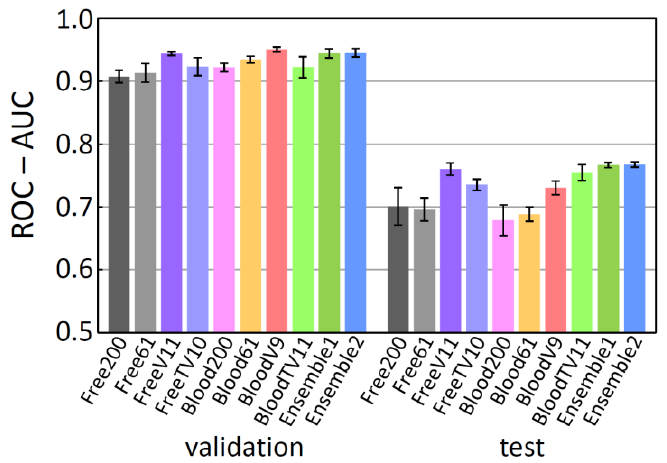
Figure 5. ROC-AUC scores of the prediction for the free-form and in-blood-form datasets obtained by DNN and ensemble methods.